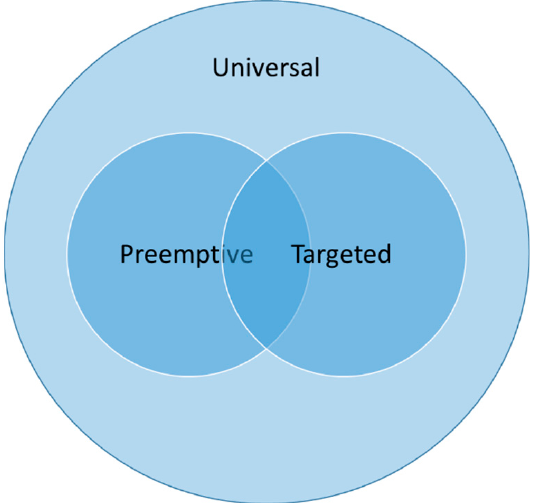
Figure 1. Invasive fungal disease prevention strategies employed in lung transplant recipients.